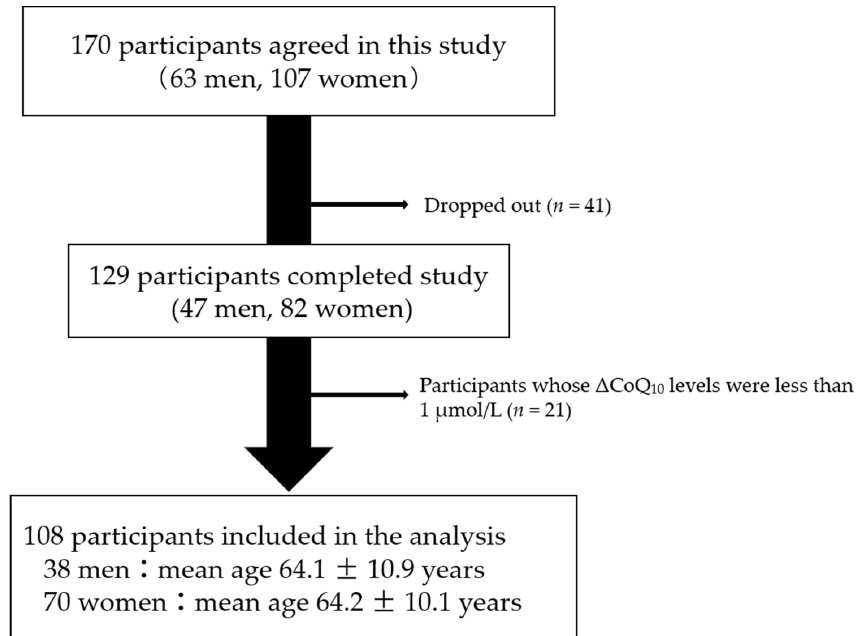
Figure 1. Flow chart describing the study design.